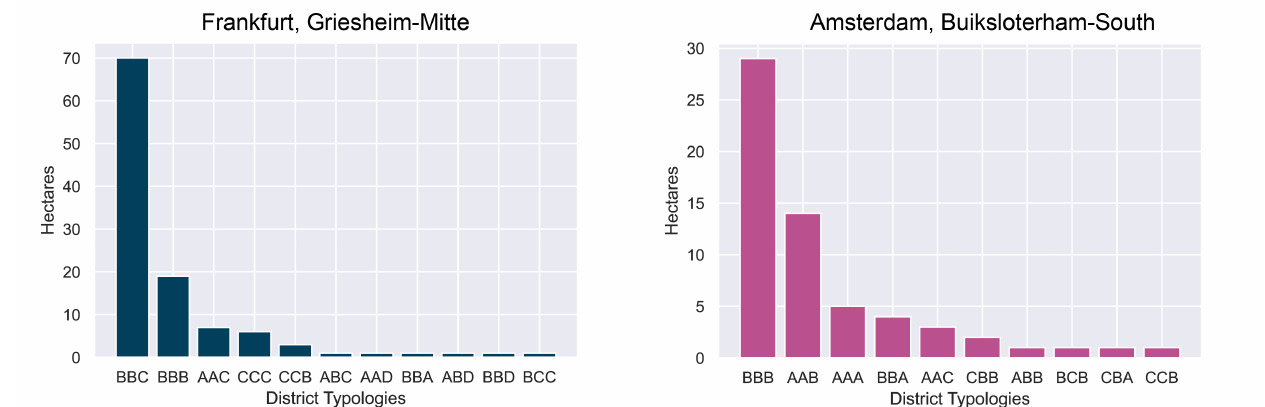
Figure 9. A comparison of the frequency of the district categories in Frankfurt - Griesheim-Mitte am Main and Amsterdam -